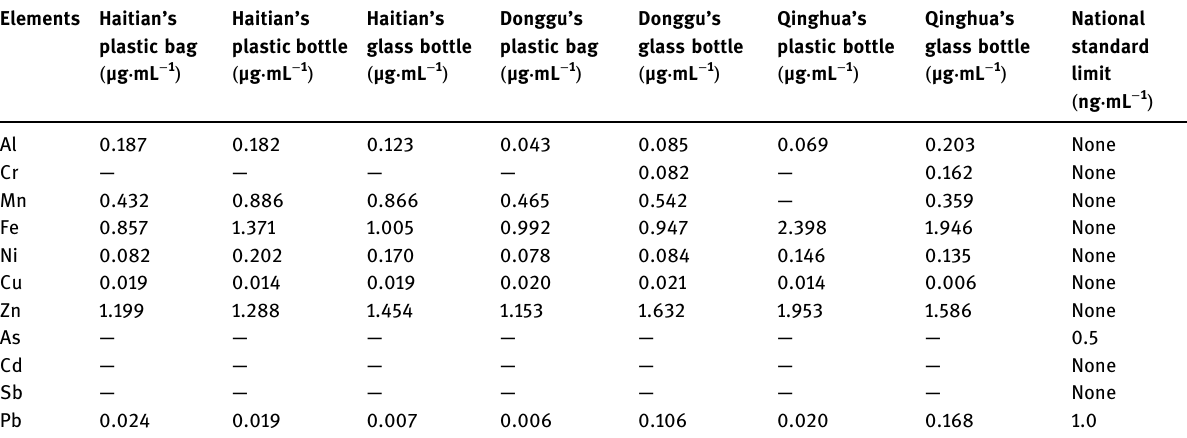
Table 7: Result of 11 trace elements in seven kinds of soy sauce samples Elements Haitian ’